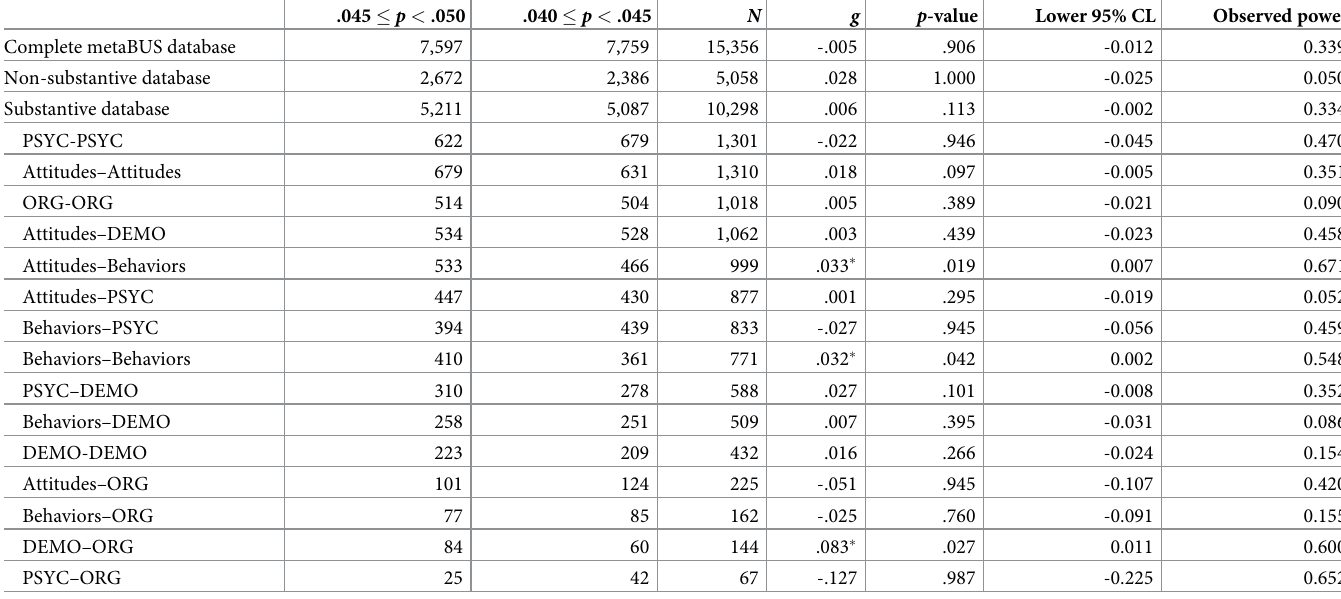
Table 5. P- hacking results according to critical bin comparisons